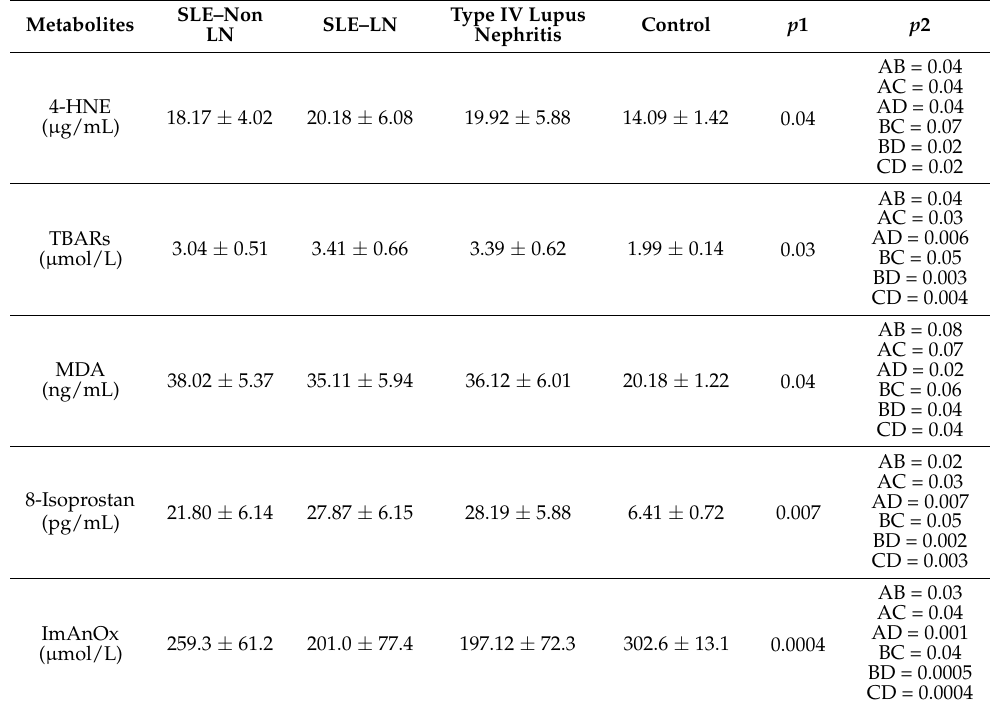
Table 3. Lipid peroxidation pattern in the studied